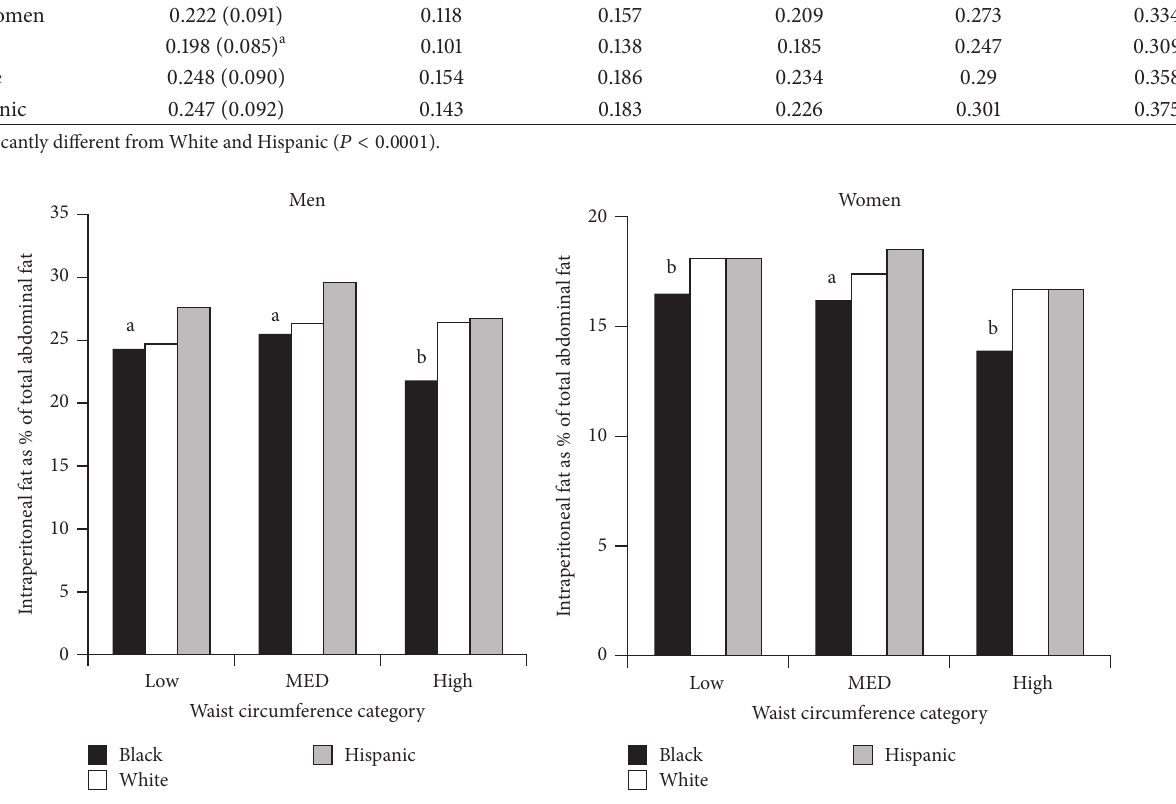
Figure 3: Percentage of intraperitoneal fat (IPF) or total abdominal fat (TAF) for each waist circumference category for ethnicity and gender. Blacks generally had a lower percentage IPF compared to whites and Hispanics. a Significantly different from whites and Hispanics ( 𝑃 < 0.02 ); b significantly different from Hispanics ( 𝑃 < 0.02